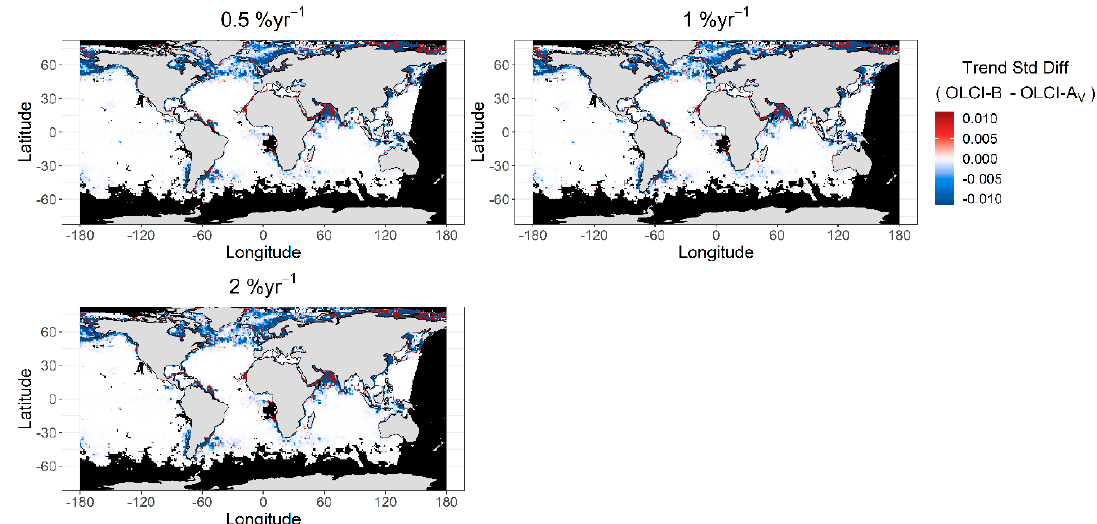
Figure A6. Global 1° maps of the differences between the standard deviation of all chl- a trend estimates from all bootstraps for OLCI-A-Vicarious and OLCI-B in each grid cell. The value expressed in percent per year above each subplot indicates the trend imposed on the synthetic time series. Blue indicates that OLCI-A-Vicarious has higher standard deviation of chl- a trend estimates than OLCI-B. Black grid cells indicate where missing data prevents analysis.